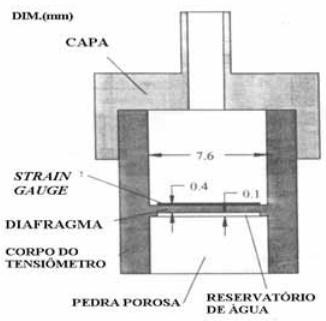
Figura 7. Tensiômetro desenvolvido na Universitá di Trento – Itália. (Tarantino &. Mongiovi,